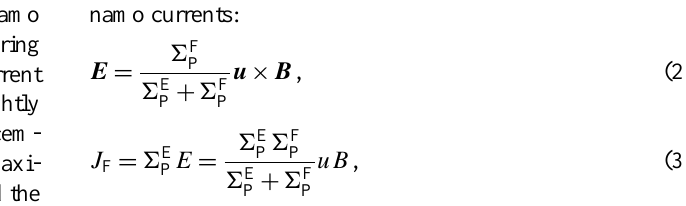
variations are quite different from season to season.